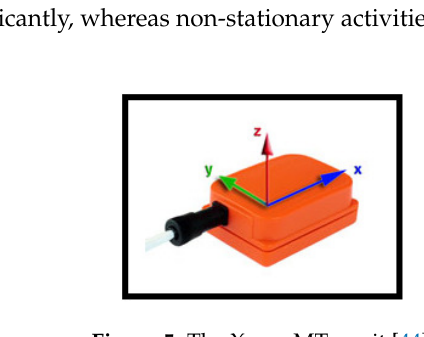
Figure 5. The Xsens MTx unit